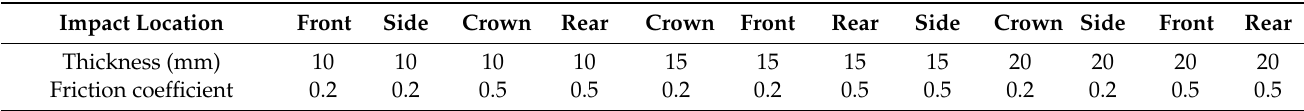
Table 3. Model setup for validation data.